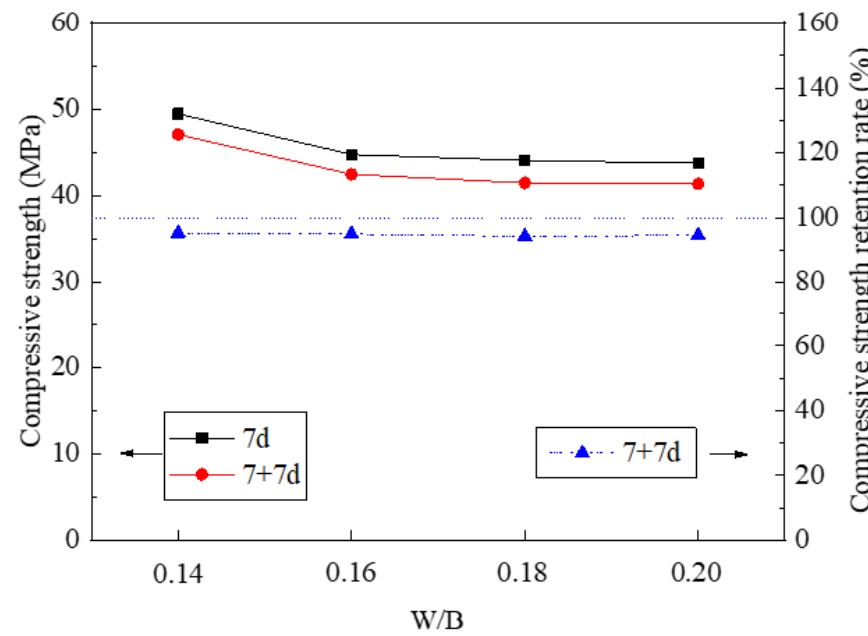
Figure 8. Compressive strength and its retention rate of HDMC with different W/B ratios.